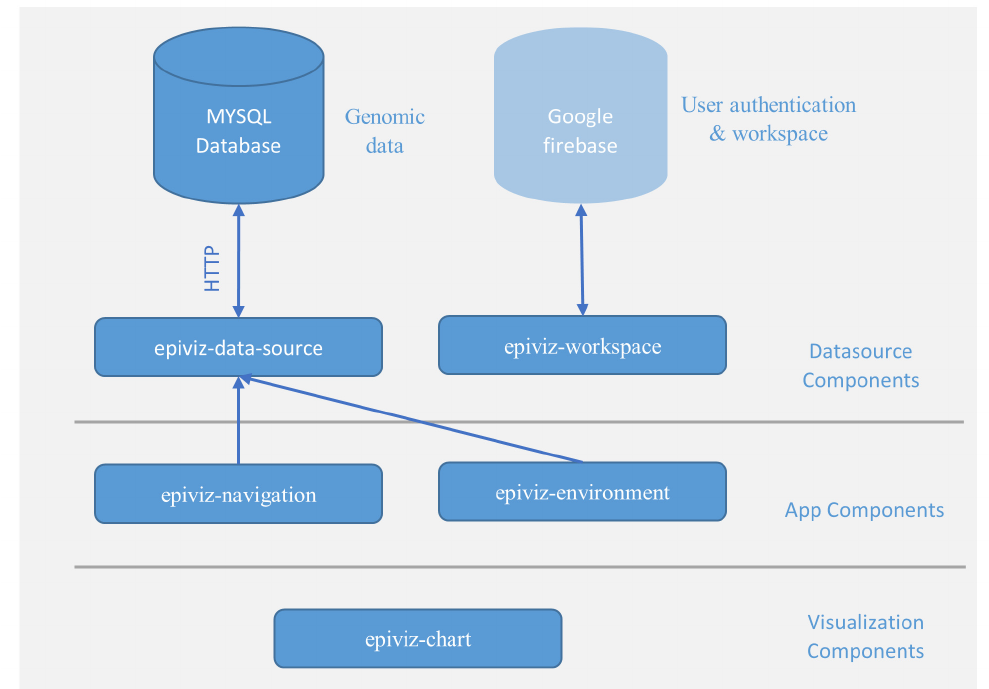
Figure 1. Overview of Epiviz web components architecture. The epiviz web components architecture is organized into three categories: 1) visualization components is a library of extensible and interactive D3JS based chart components specifically designed for genomic data; 2) app components are responsible for managing the layouts, events arising from genomic coordinate navigation, linking data across visualization components to implement brushing and coordinating data requests across multiple charts; 3) datasource components manage requests to web server or WebSocket connections using the epiviz-data-source component. epiviz-workspace handles user authentication and saves the state of the app to a google firebase instance allowing users to create shareable and reproducible visual analytics